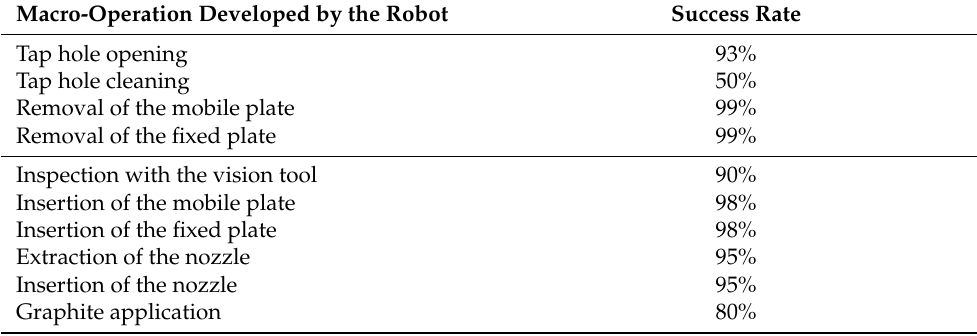
Table 2. Outcomes of the field tests of the robotic workstation in terms of success rate of each